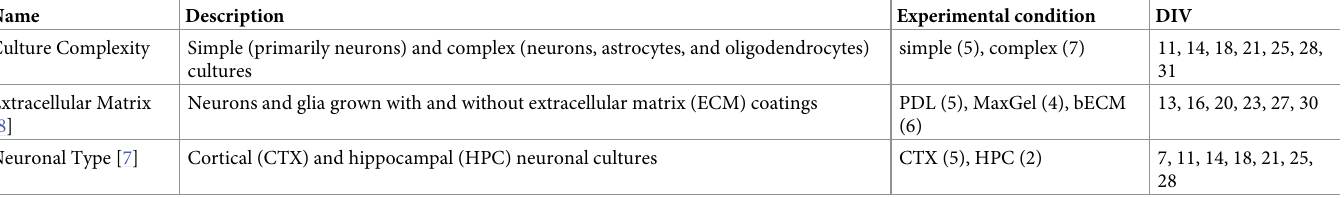
Table 1. Datasets used in our experimental evaluation. In the “Experimental condition” column, the numbers in the parenthesis indicate the number of MEA devices for the corresponding experimental condition.